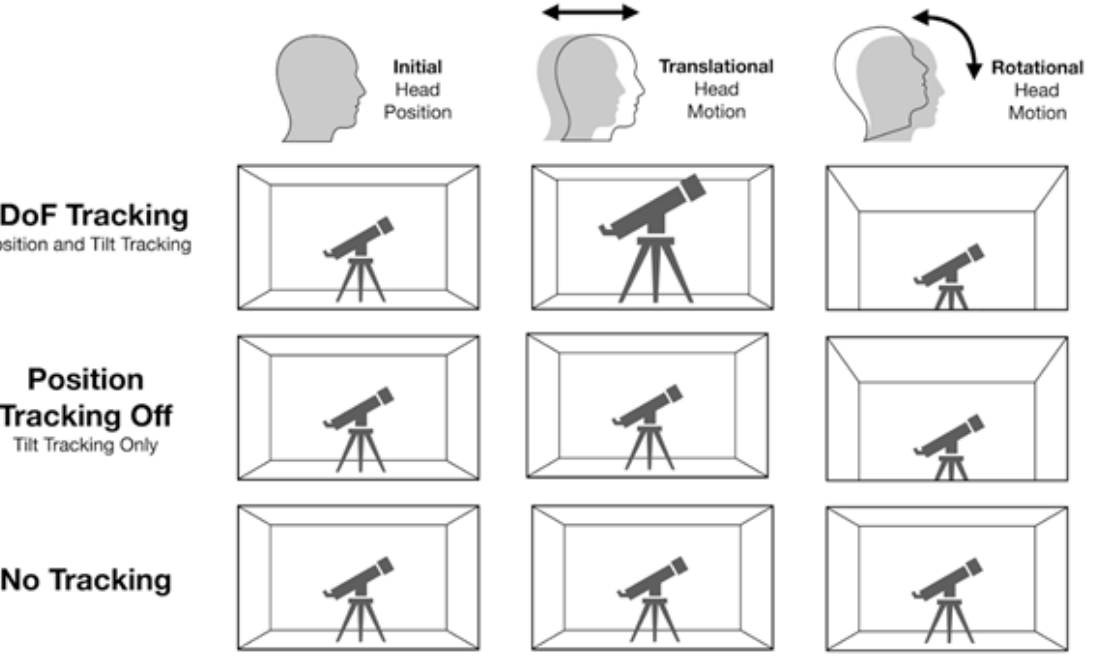
Figure 1. Effect of the head tracking condition in virtual reality on a user's view with translation or rotation of the head. 6DoF: six degrees of